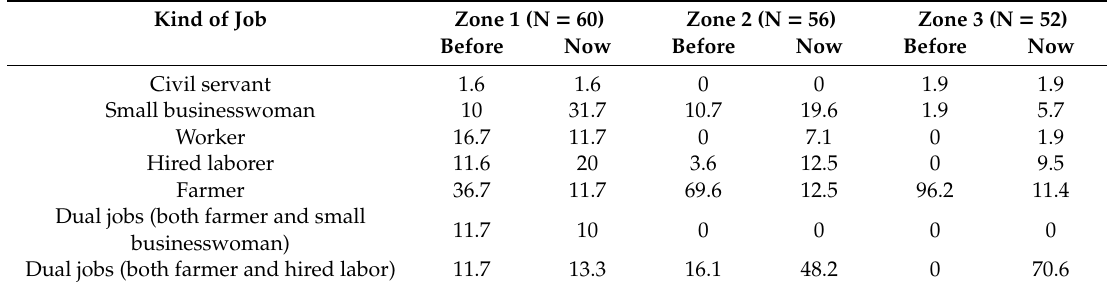
Unit: Percentage of women; Source: Data from household survey 2018.